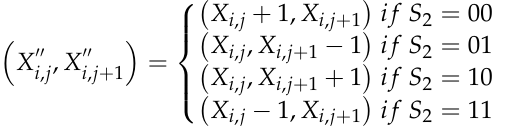
Table 1. Combination states and secret data values for data extraction